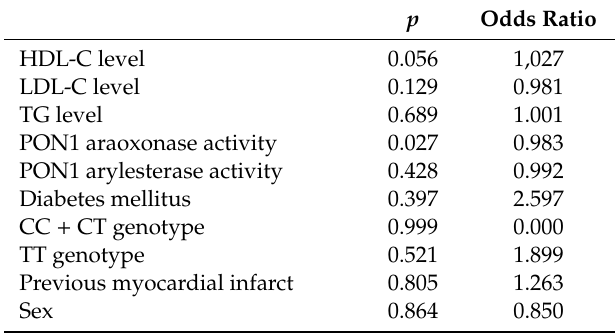
Table 6. Results of logistic regression analysis for association of family history of cardiac episode with independent